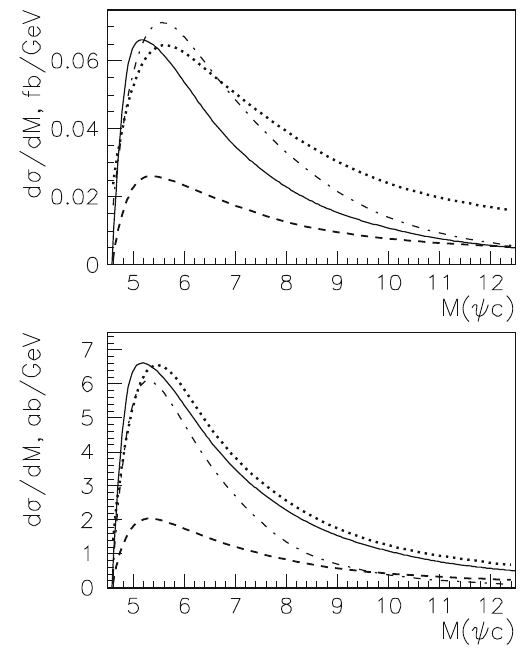
Fig. 9 The process γ + γ → J /ψ + c + ¯ c ; the distributions over Fig. 8 The process γ + γ → J /ψ + c + ¯ c ; invariant mass of the the fragmentation variable z as seen under the different kinematic J /ψ + c systemasseenunderthedifferentkinematicconstraints.Upper > 20 GeV; constraints. Upper panel: dotted, p ψ T > 5 GeV, p ∗ > 20 GeV; dashed, p ψ > 20 GeV, panel: dotted, p ψ T > 5 GeV, p ∗ T T T > 20 GeV; dash-dotted, m ∗ < E ∗ / 3; dashed, p ψ T > 20 GeV, p ∗ > 20GeV;dash-dotted, m ∗ < E ∗ / 3;solid,factorizationcalculation p ∗ T T > 20 GeV. Lower panel: dot- solid, factorization calculation for p ∗ > 20 GeV. Lower panel: dotted, p ψ > 20 GeV, p ∗ > 50 GeV; for p ∗ T T T T > 50 GeV; dashed, p ψ > 50 GeV, ted, p ψ T > 20 GeV, p ∗ > 50 GeV; dash-dotted, m ∗ < E ∗ / 10. dashed, p ψ T > 50 GeV, p ∗ T T T > 50 GeV; dash-dotted, m ∗ < E ∗ / 10; solid, factorization cal- p ∗ > 50 GeV solid, factorization calculation for p ∗ T T > 50 culation for p ∗ T